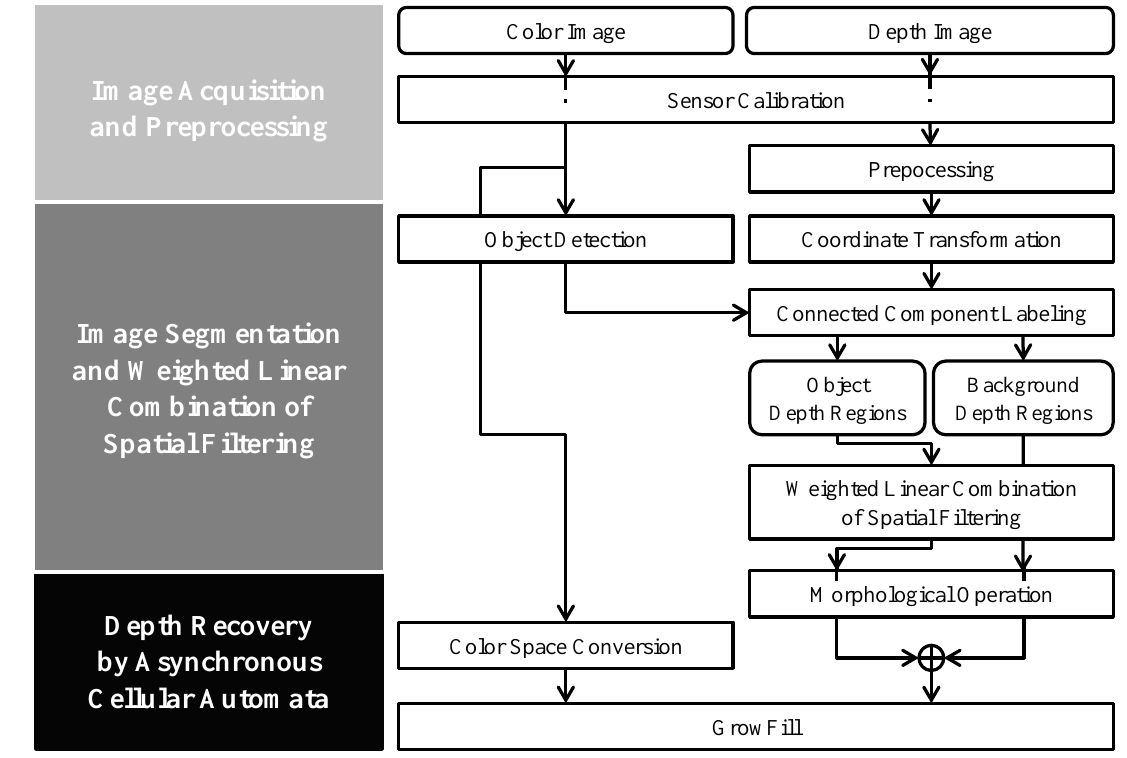
Figure 2. Flowchart of the proposed method.